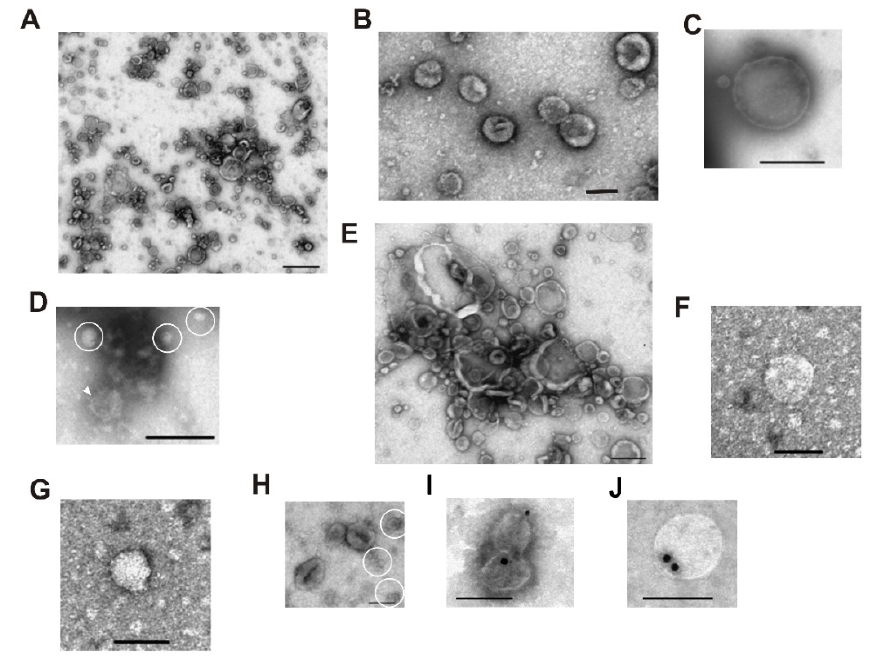
Figure 4. Transmission electron microscopy of horse milk exosomes on different stages of isolation and purification. P2 subfraction was obtained after affinity chromatography on anti-CD9-Sehparose ( A – D , I ) and anti-CD63-Sepharose ( E – H , J ). General view ( A , E ); exosomes of ≤ 100 nm ( B , F ); vesicles > 100 nm ( C ); exosomes (white arrow) and particles of medium electron density without outer membranes (ovals) ( D ); particles of medium electron density without outer membranes ( G ); vesicles, “non- vesicles”, particles of medium electron density without outer membranes ( H ); gold immunolabeling using anti-CD9-IgG ( I ) and anti-CD63-IgG ( J ). The length of the scale line corresponds to 100 nm ( B , D , F – J ) and 200 nm ( A , C , E